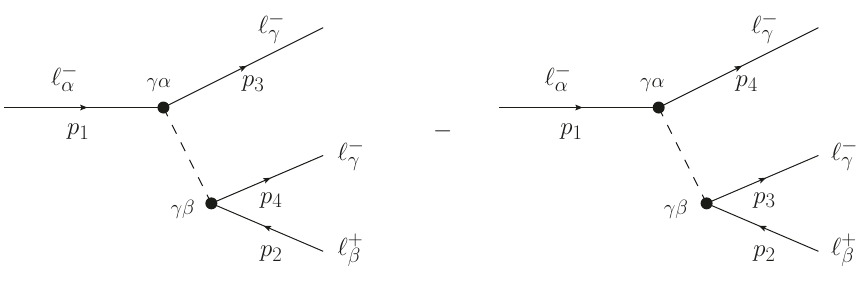
→ ‘ + ‘ − ‘ − described by α γ γ β